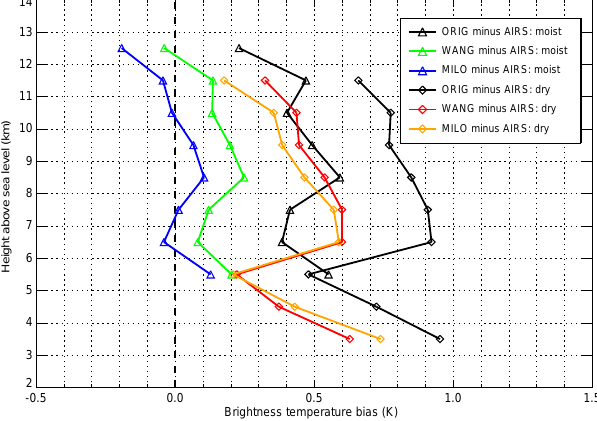
Figure 9. The median LBLRTM minus AIRS brightness tempera- ture difference (residual) as a function of height (for all data), where the residual in a spectral channel was assigned to a particular height (in 1km intervals) based upon where the weighting function for that channel peaked with altitude (using the original RH profile). Error bars represent the 25th/75th percentile of brightness tempera- ture residuals.